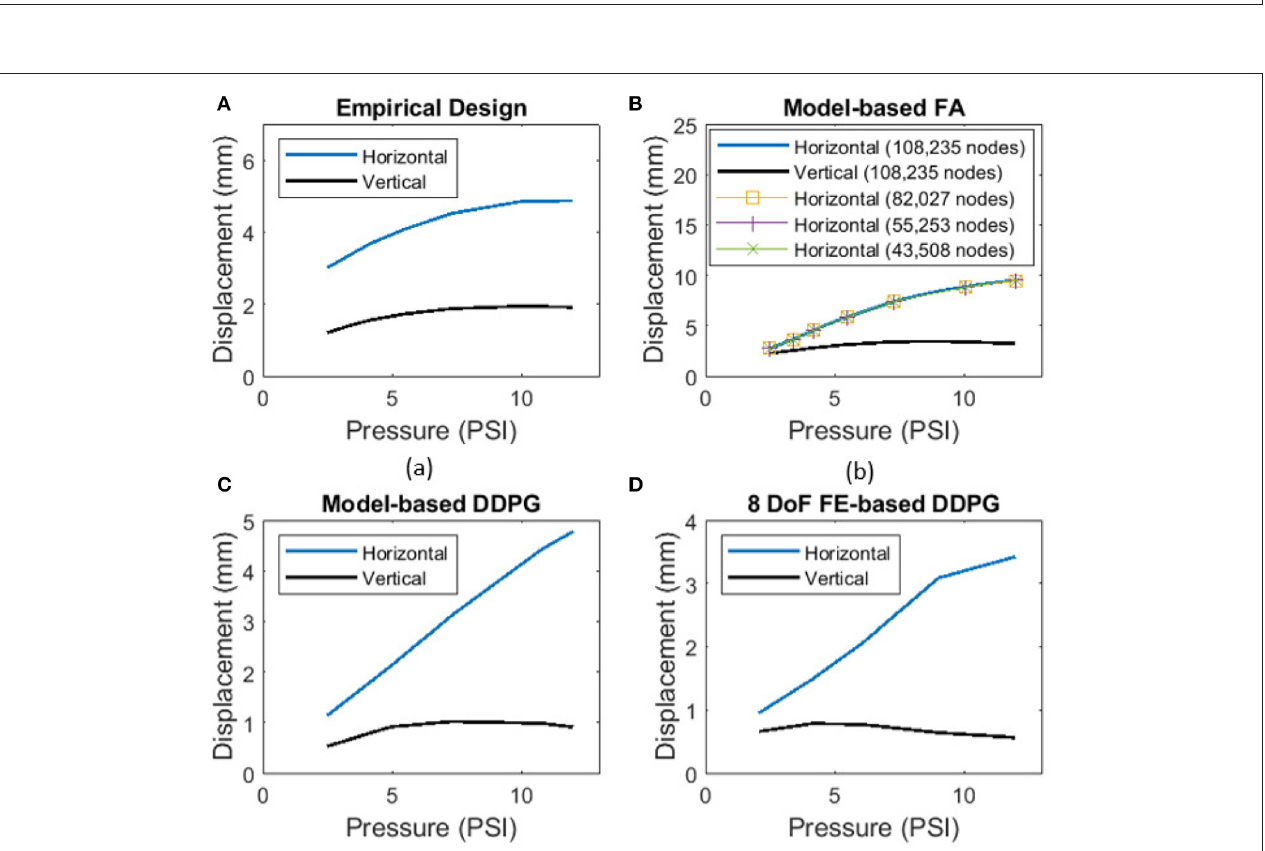
FIGURE 8 | Relationship between horizontal displacement and applied pressure from FE-based computational models for all (A) empirical design, (B) model-based FA, (C) model-based DDPG, (D) 8-DoF FE-based DDPG optimization designs. Convergence is shown for nodes in model-based FA in (B) .